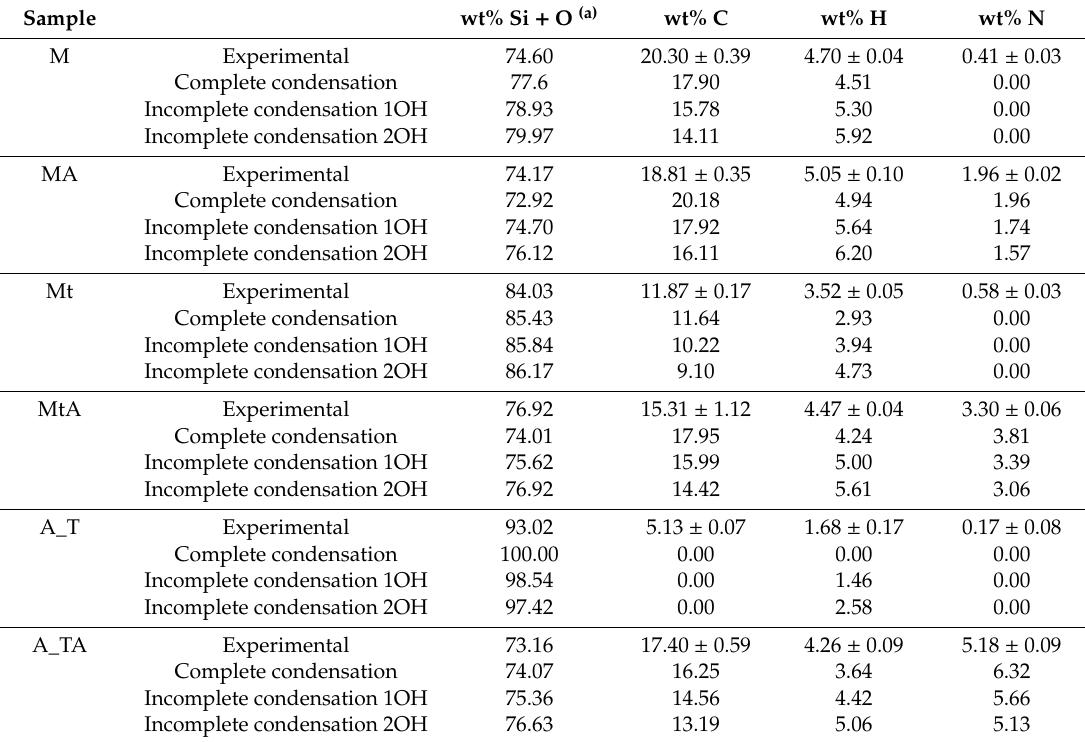
Table 3. Experimental and theoretical percentages of chemical elements in the